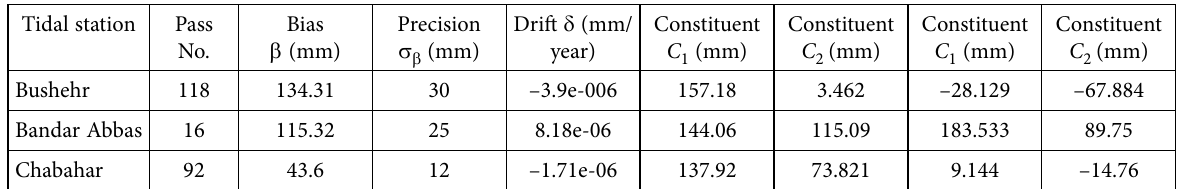
Table 6. Bias, drift and annual/semiannual constituents of jason-1 estimated by the coastal tide gauge stations at Bushehr, Bandar Abbas and Chabahar